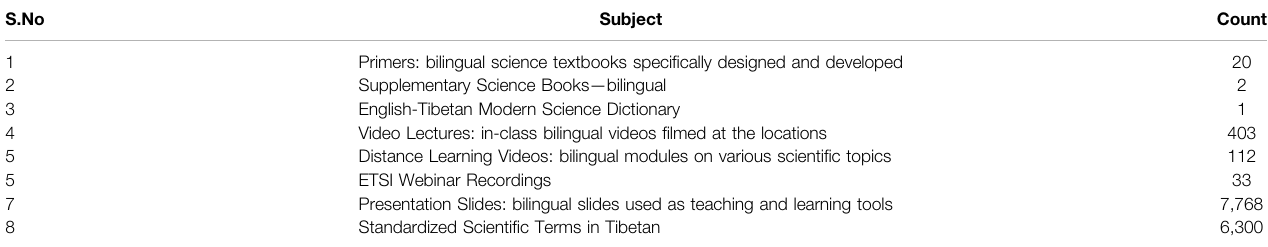
TABLE 1 | Science textbooks and other bilingual educational materials produced by ETSI to